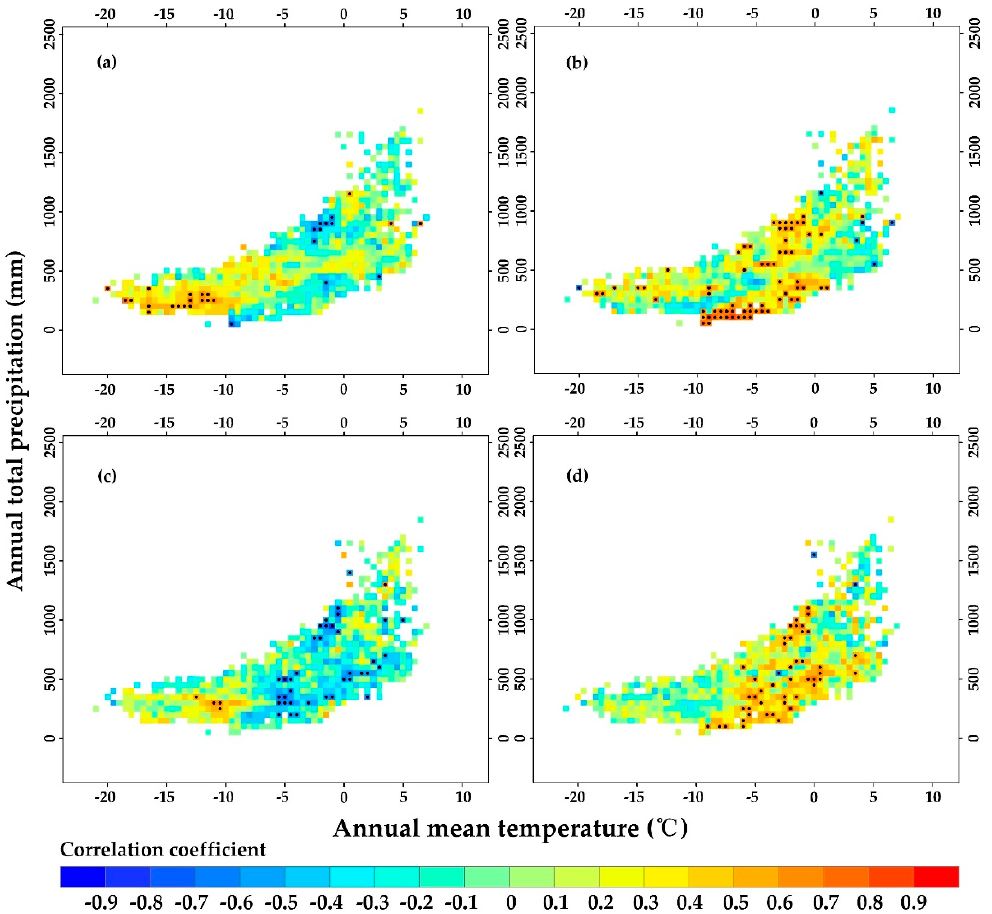
Figure 8. The variation in the partial correlation coefficient between snow cover phenology and spring phenology and annual maximum enhanced vegetation index along the temperature and precipitation gradient in the boreal region. ( a ): Partial correlation coefficient between start of growing season (SOS) and snow cover duration (SCD); ( b ): start of growing season (SOS) and snow cover end date (SCE); ( c ): annual maximum enhanced vegetation index (EVI max ) and snow cover duration (SCD); ( d ): annual maximum enhanced vegetation index (EVI max ) and snow cover end date (SCE). The circles indicate the pixels with a significant correlation ( p < 0.05).